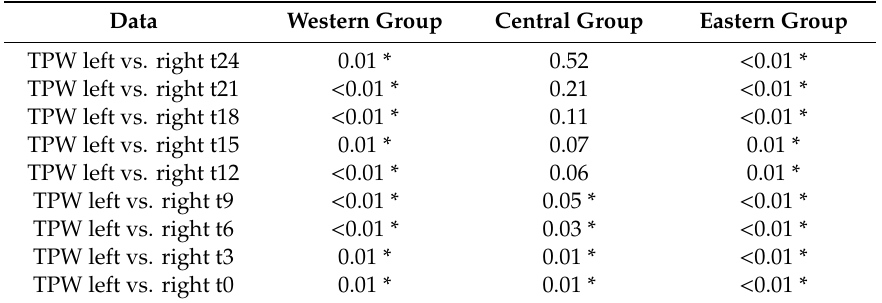
Table 5. As in Table 4 but for the averaged TPW on the left side versus on the right side of the storm. Data